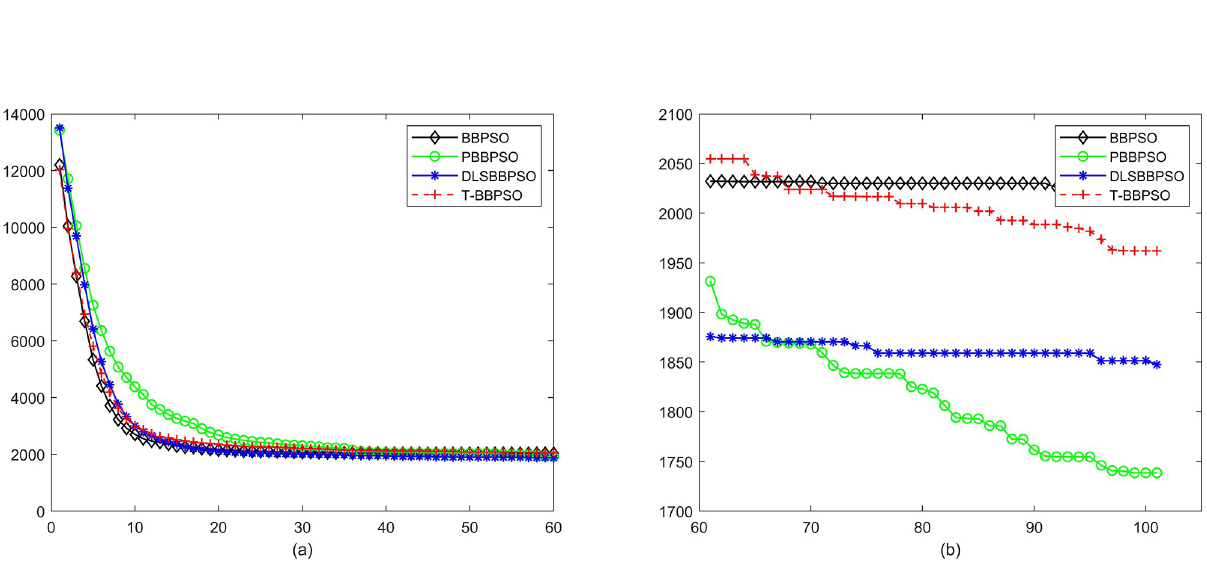
Fig 12. Comparison of convergence speed between BBPSO, PBBPSO, DLS-BBPSO and TBBPSO, f 10 , (a) iteration 0–6000, (b) iteration 6000–10000 the unit is 100 iteration.